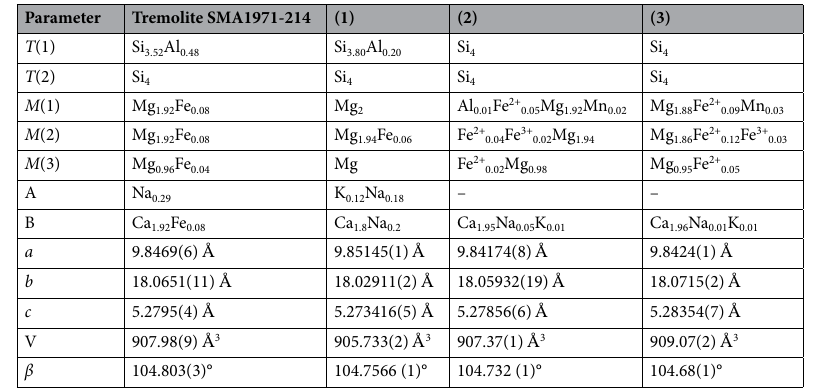
Table 2. Site populations and unit cell parameters of tremolite SMA1971-214 compared to reference data: (1) tremolite from Gouverneur Mining District (NY, USA) 57,58 . (2) tremolite from Susa Valley (Piedmont region, Italy) 59 . (3) tremolite from Ala di Stura (Lanzo Valley, Piedmont region, Italy) 60